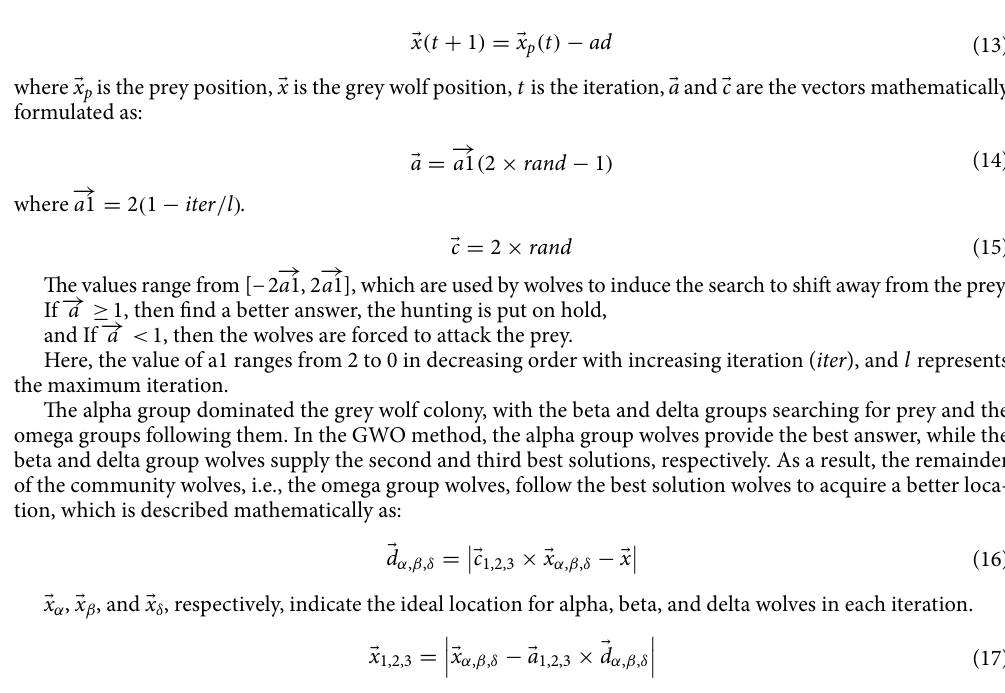
1 ) describes the updated location of the prey in ( the t x p ( t Here, � + mean position of the three best wolves in the population, that is,